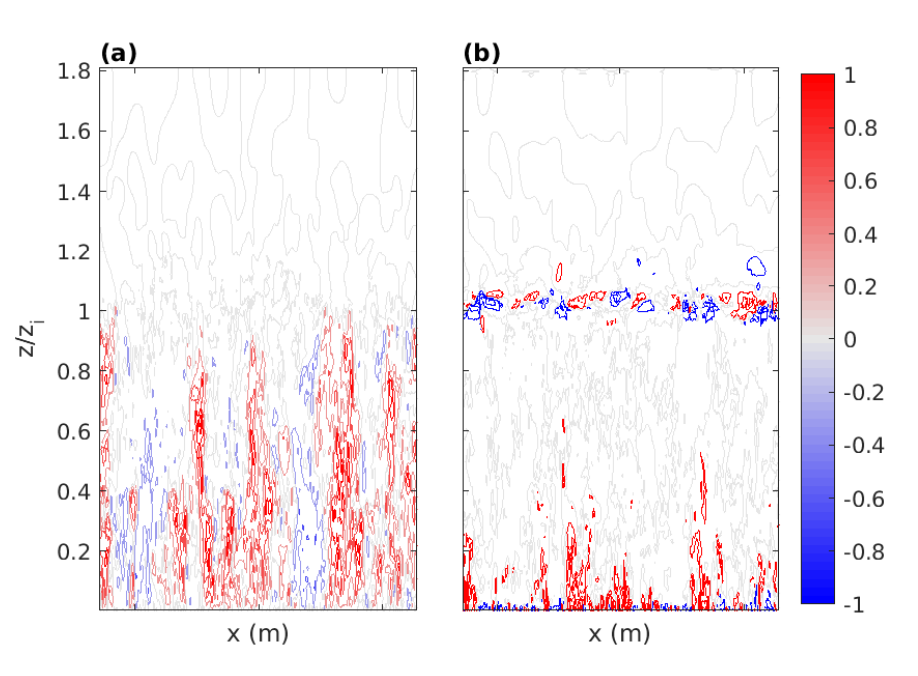
Figure 7. Vertical cross-sections of ( a ) vertical velocity and ( b ) potential temperature perturbation for the 10 m grid length “truth run” of CBL1. The range of values that provides a normalization factor for the colour bar in ( a ) is − 1.5 to 1.5 ms − 1 and in ( b ) is − 0.1 to 0.1